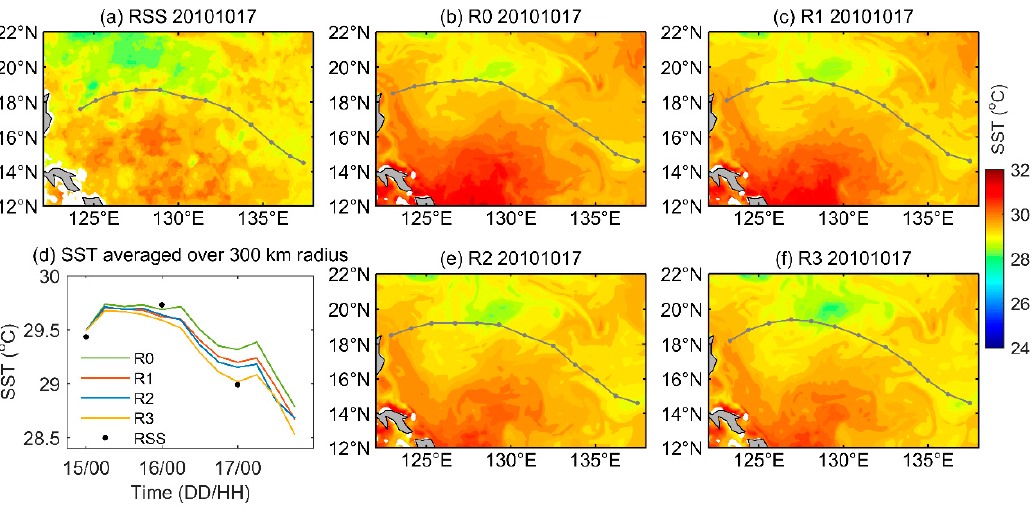
Figure 11. Daily mean SST on 17 October 2010 for Megi. ( a ) SST from RSS observations; ( b , c , e , f ) simulated SSTs from R0, R1, R2, and R3, respectively; ( d ) time series of SSTs averaged over 300 km radius inner core region along Megi center location.